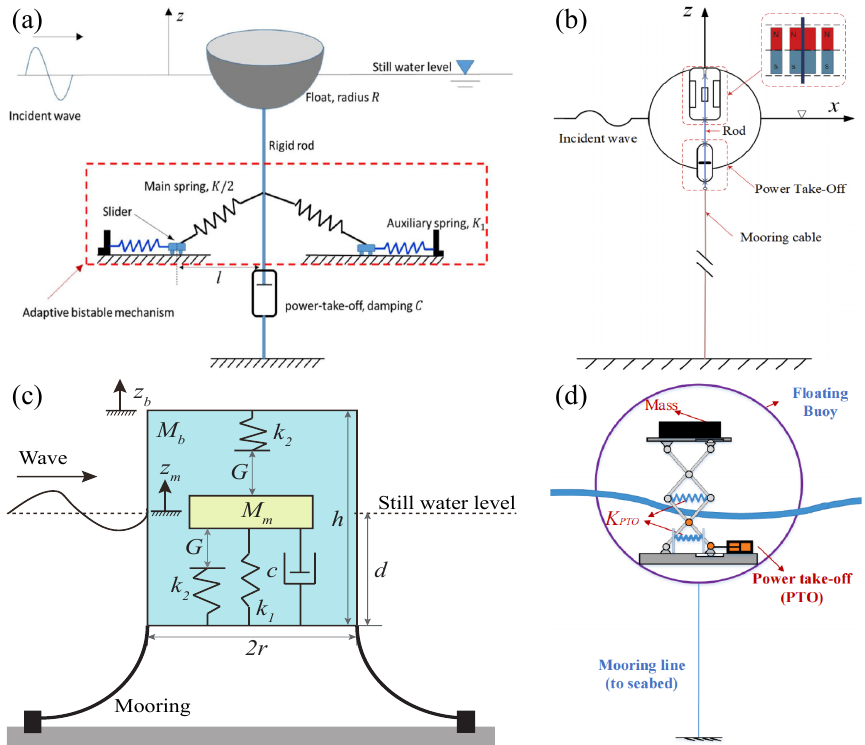
Figure 22. Bistable mechanisms in PTO design, with mechanical, magnetic, vibro-impact and X- structured bistable mechanisms, shown in ( a – d ), respectively, adapted from